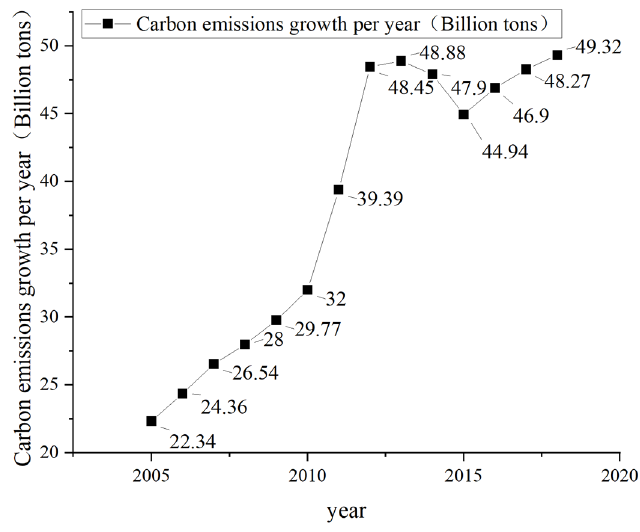
Figure 1. Growth of carbon emissions in China from 2005 to 2018.